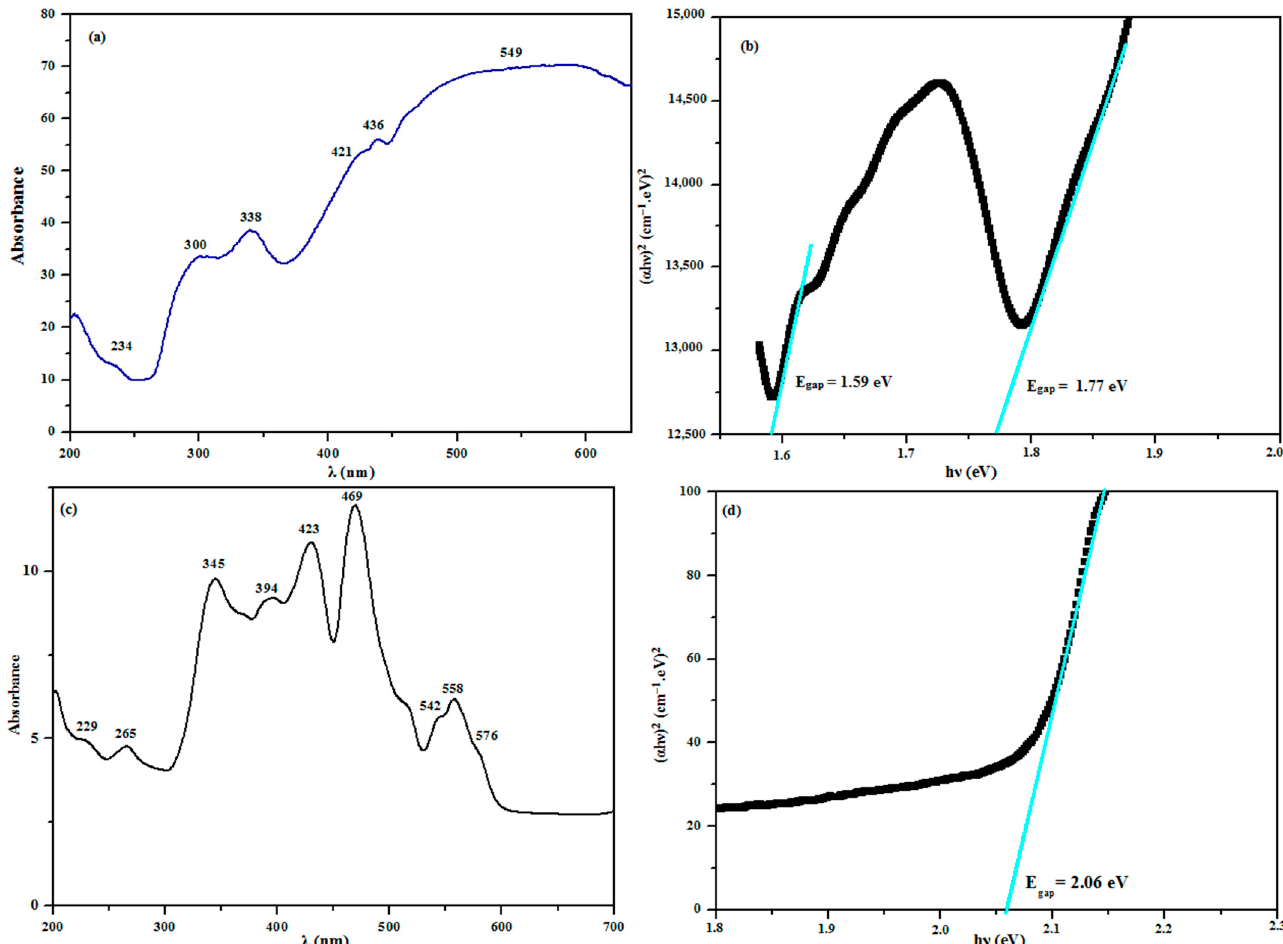
Figure 9. ( a , b )UV – Vis spectrum associated with the Taucplot (( α hv) 2 versus hv) for compound ( I ); ( c , d ) UV – Vis spectrum associated with the Taucplot (( α hv) 2 versus hv) for compound ( II ).